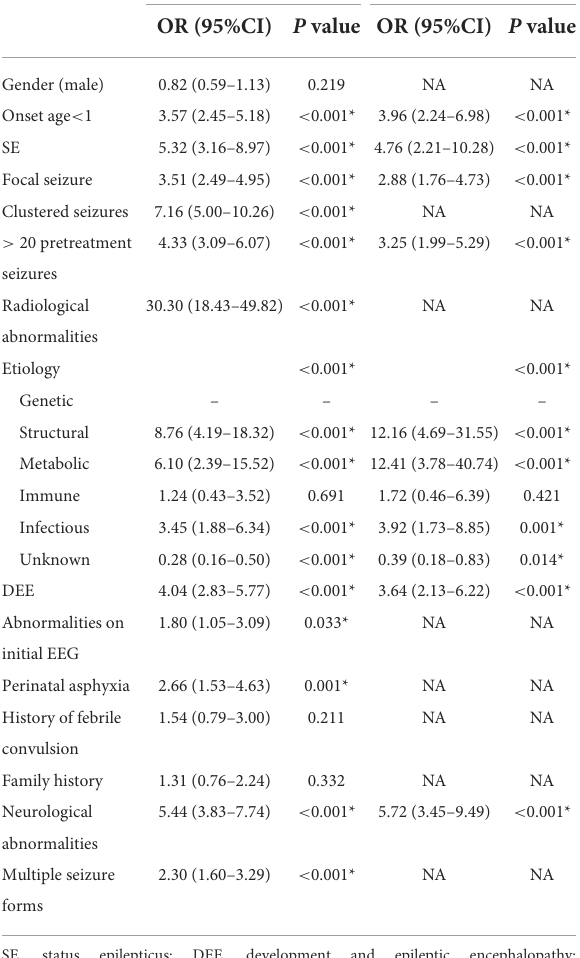
TABLE 2 Univariate and multivariate logistic regression in the training set. Univariate analysis Multivariate analysis